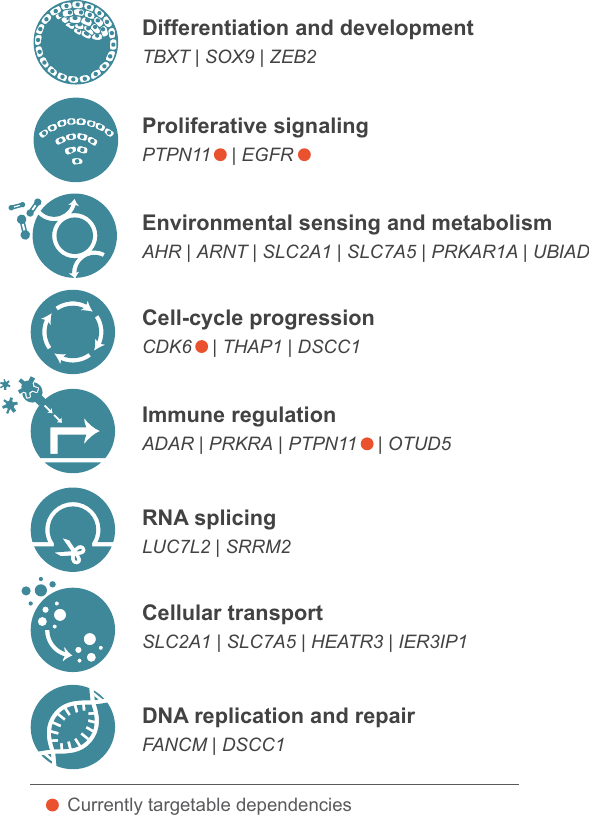
Fig. 6 | Functional classi fi cation of chordoma dependency genes.